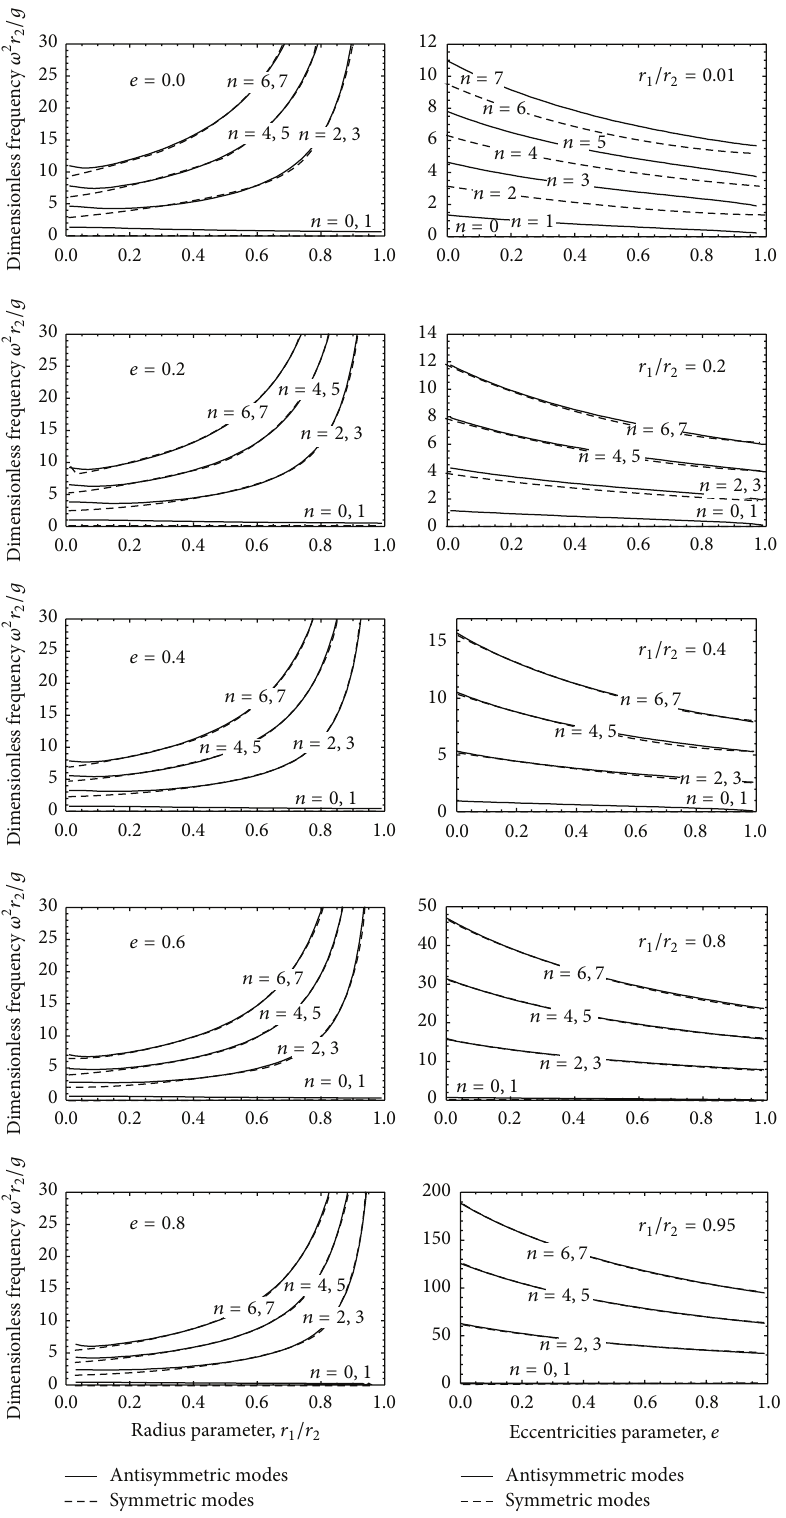
Figure 4: Variation of the wave motion frequencies with radii ratio and eccentricity